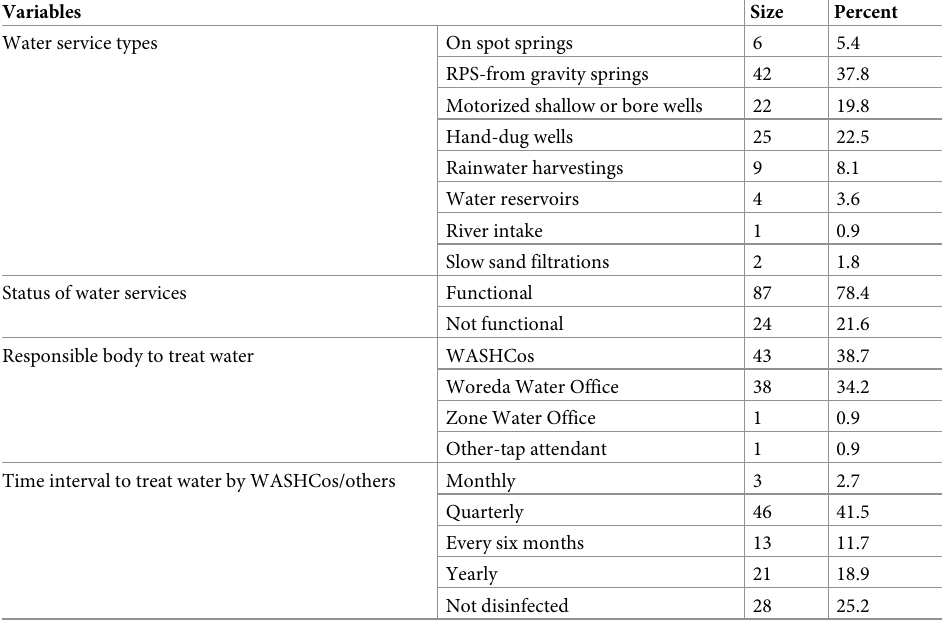
Table 3. Results of the technical variables.